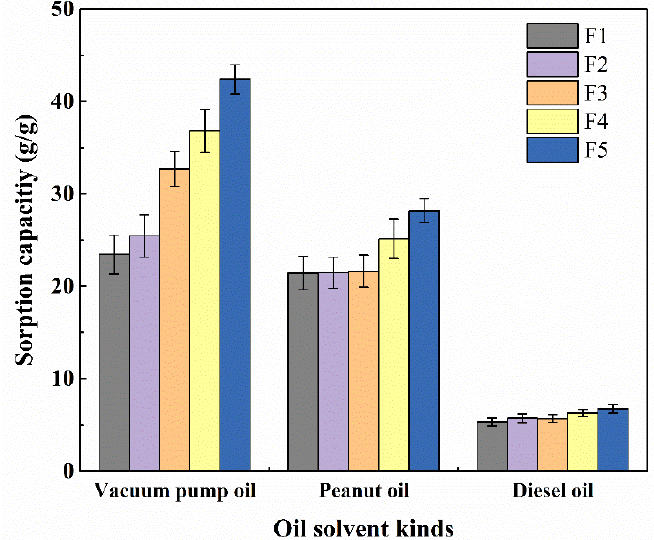
Table 1. viscosity of different types of oil.